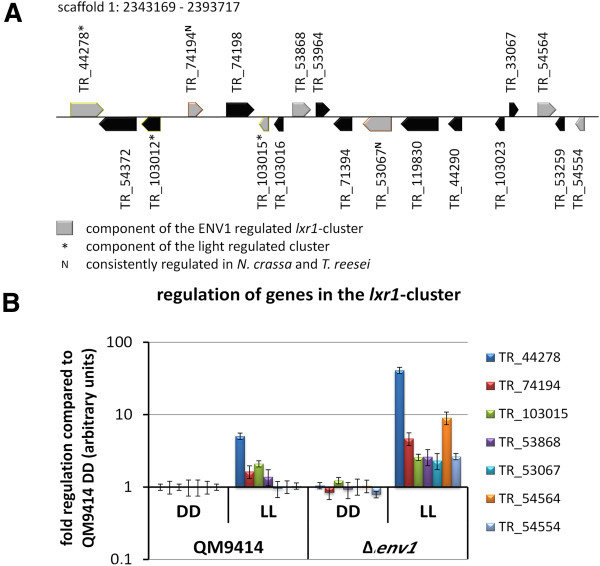
Schematic representation of the ENV1-regulated lxr1 genomic cluster. (A) The genomic region comprising the lxr1 cluster is drawn to scale. Besides genes regulated by ENV1, further genes are located within this genomic region, which are given in black. Genes regulated by light on cellulose are given with yellow frames, those consistently regulated in N. crassa are shown with an orange frame. (B) Regulation of the lxr1 cluster genes in QM9414 and ∆env1 in light and darkness. No significant regulation of these genes was observed in the blr mutants.